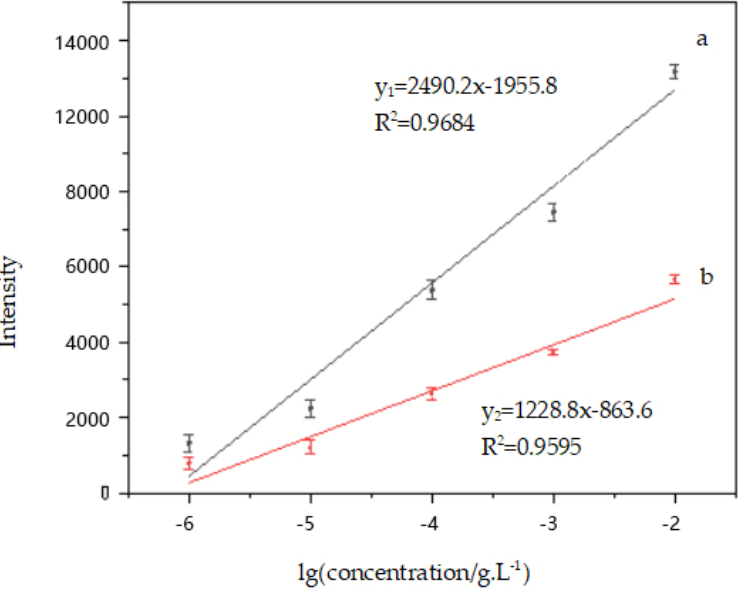
Figure 10. The linear correlations between the SERS intensity and the logarithm of phenanthrene concentration. (a) 415.24 cm − 1 ; (b) 690.24 cm − 1 .